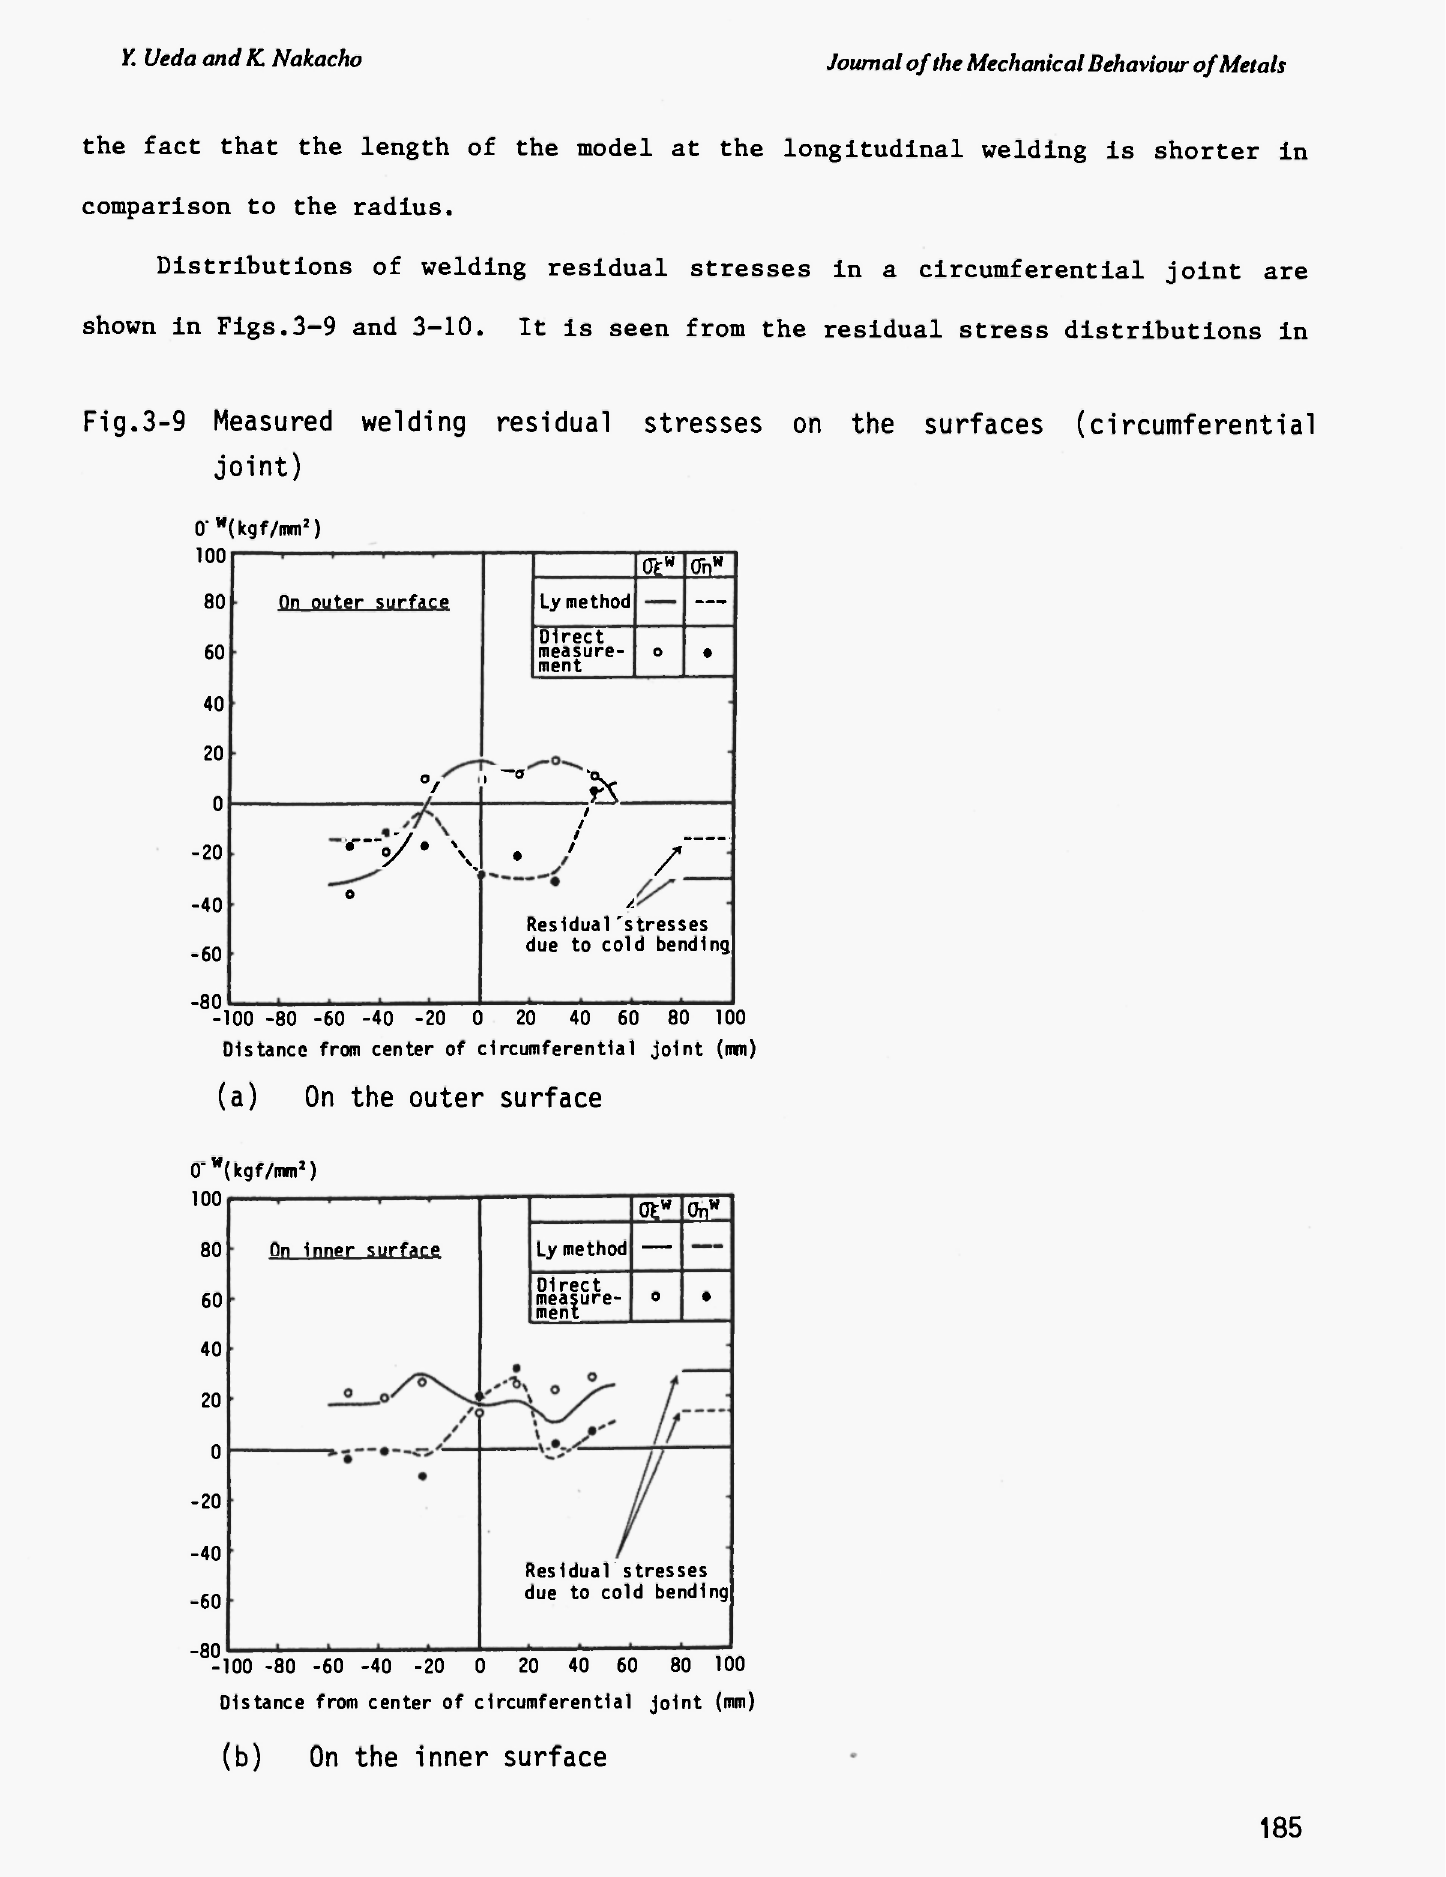
Measured welding residual stresses on the surfaces